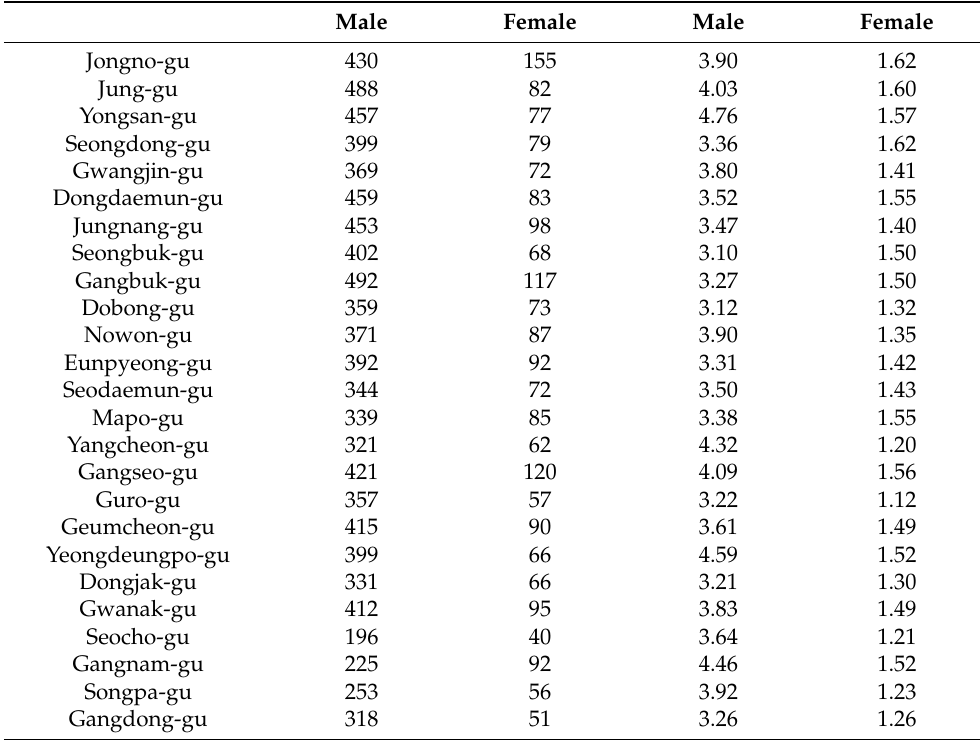
Table 3. SIIs per 10,000 and RIIs of 25 districts of Seoul for the period from 2014 to 2018 for men and women. Male Female Male